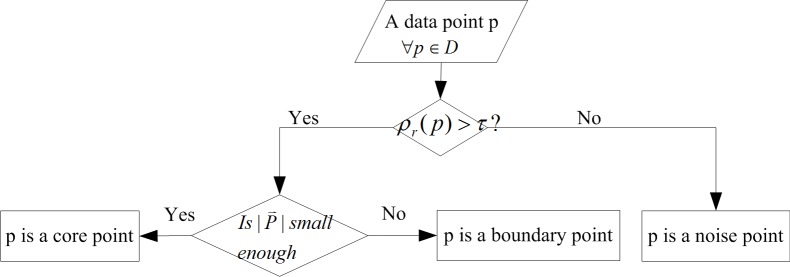
The discriminant tree of a data point.